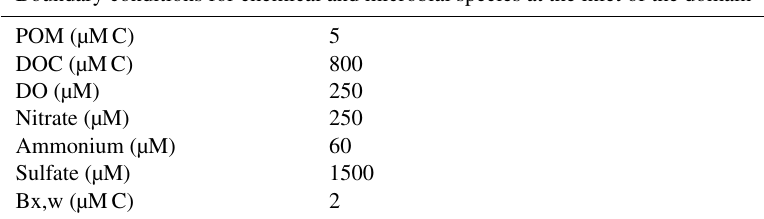
Boundary conditions for chemical and microbial species at the inlet of the